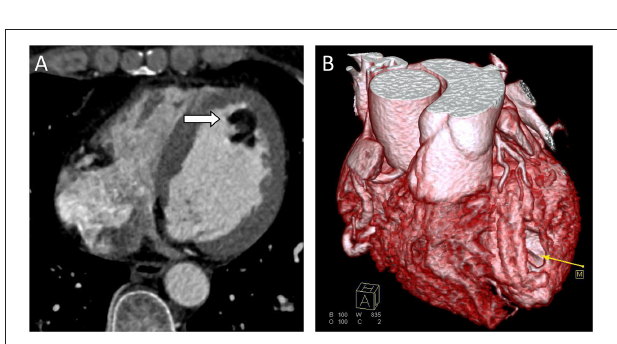
FIGURE 2 | Computed Tomography (CT) scans. (A) CT scan showing a well-defined hypodense tumor in the left ventricle (arrow). (B) CTA 3D reconstruction; hypodense tumor (yellow